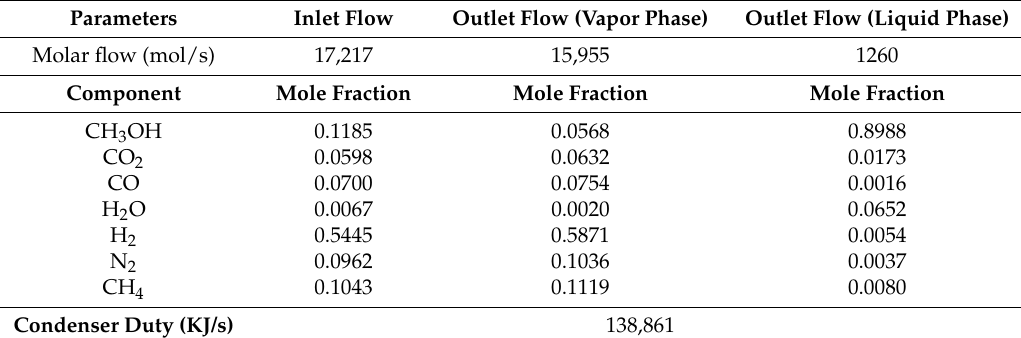
Table 7. Molar flow rates and compositions of inlet flow, outlet flows, and energy requirement of condenser in ACW